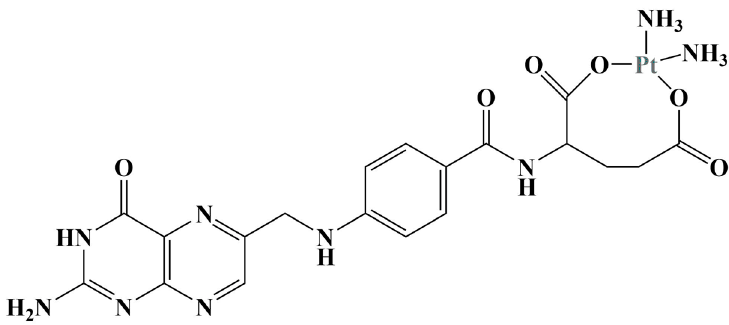
Figure 2. The folate-Pt(II) complex described in [24].